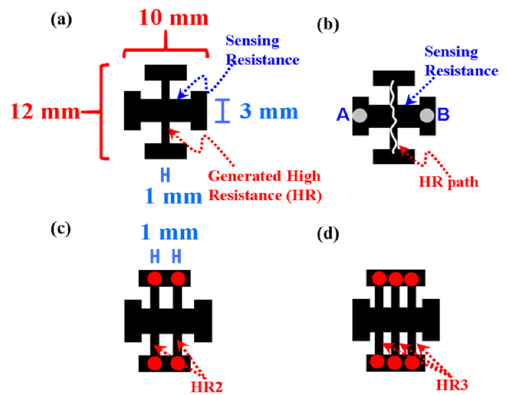
Figure 1. ( a ) Inkjet-printed +-shape piezoresistive (PR) strain sensor pattern. ( b ) The +-shape pattern constructed from two shapes of horizontal and vertical I. The horizontal and vertical I shapes were designed for the sensing PR resistance and the generation of the high resistive (HR) path, respectively. PR strain sensor pattern with ( c ) two and ( d ) three HR paths. The red circle denotes the measurement electrode for the generation of the HR paths.